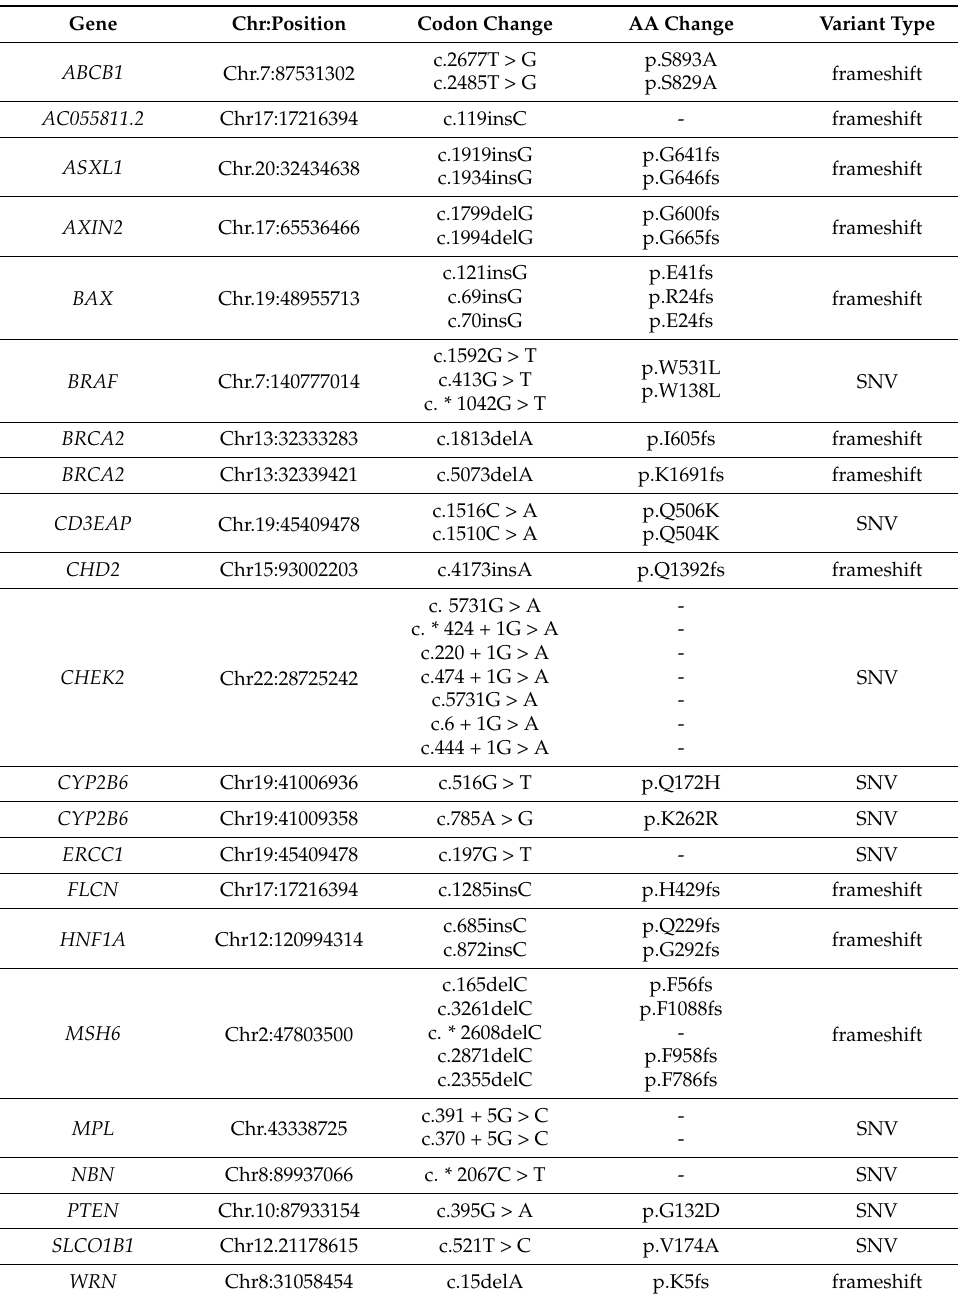
Table 2. Genetic variants identified in plasma cfDNA. Chromosome location, amino acid (AA) change, codon change and variant type are